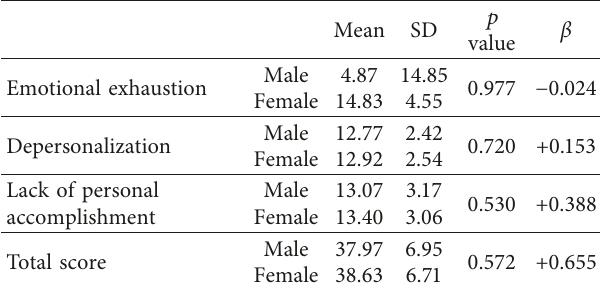
Table 3: Relationship between burnout dimensions and gender in